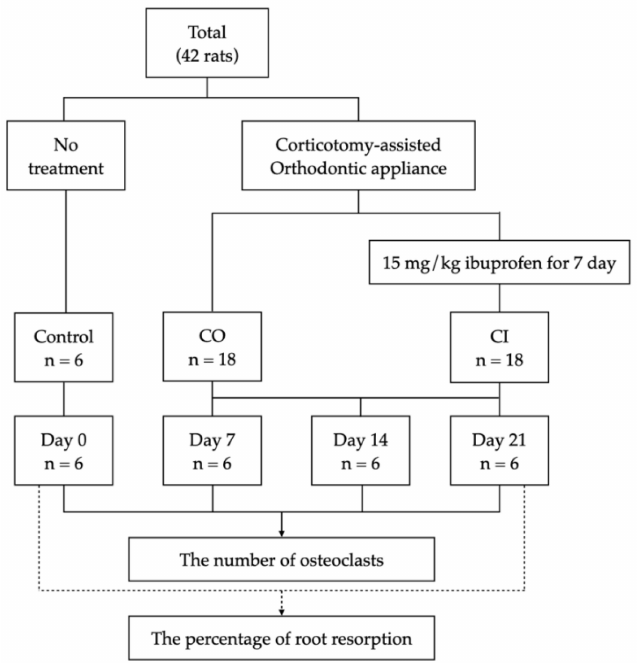
Figure 1. Schematic representation of the experimental design and